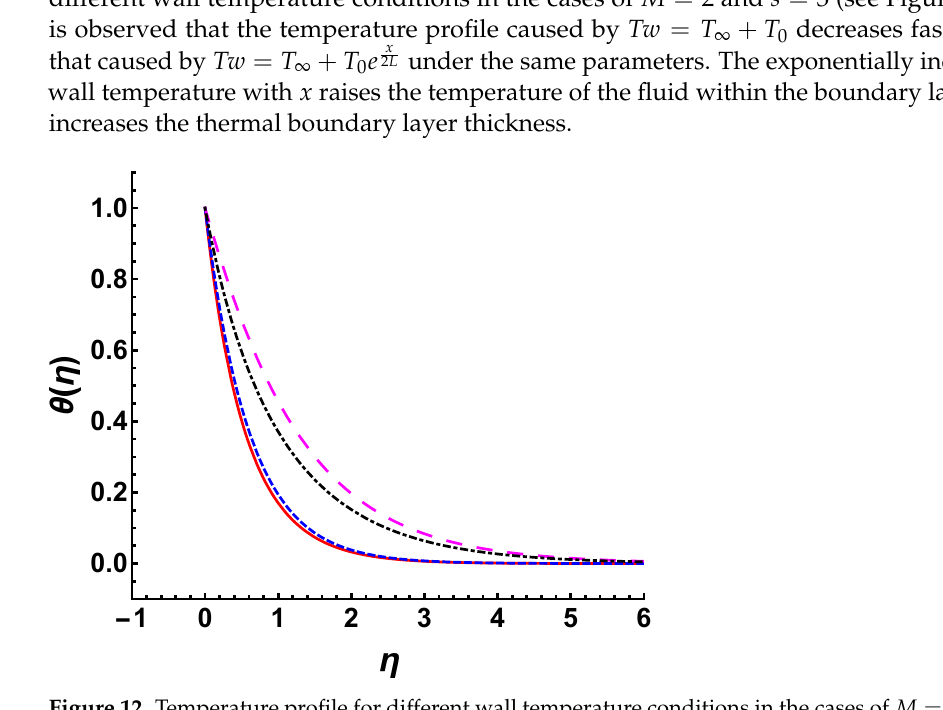
Figure 12. Temperature profile for different wall temperature conditions in the cases of M = 2 ( γ = 1, s = 2, Pr = 0.71) and s = 3 ( γ = M = 1, Pr = 0.71), respectively. Long-dashed line: Tw = T ∞ + T 0 e x 2 L , M = 2; dot-dashed line: Tw = T ∞ + T 0 , M = 2; short-dashed line: Tw = T ∞ + T 0 e x 2 L , s = 3; solid line: Tw = T ∞ + T 0 , s =